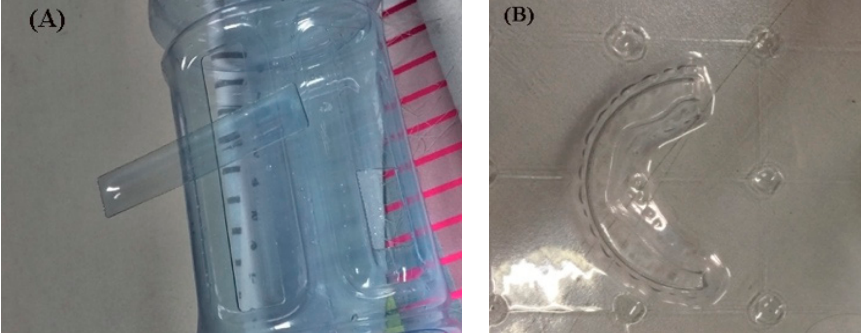
Figure 16. ( A , B ): Physical demonstration to show the laser cutting of polyethylene terephthalate (PET) at different parametric settings.